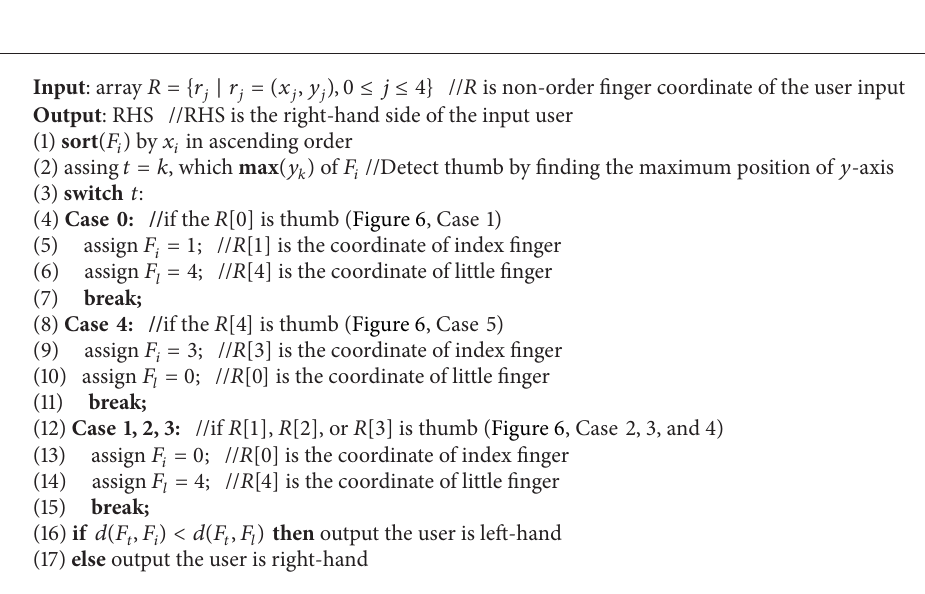
Algorithm 3: Check right-hand